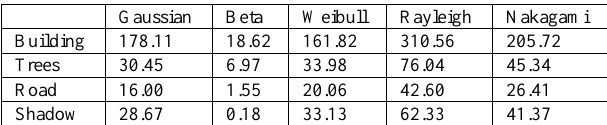
Table 1. The Kullback-Leibler divergence for each model and each land